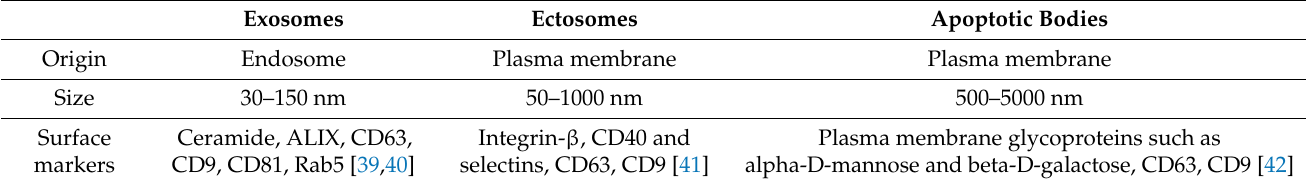
Table 1. Main features of extracellular